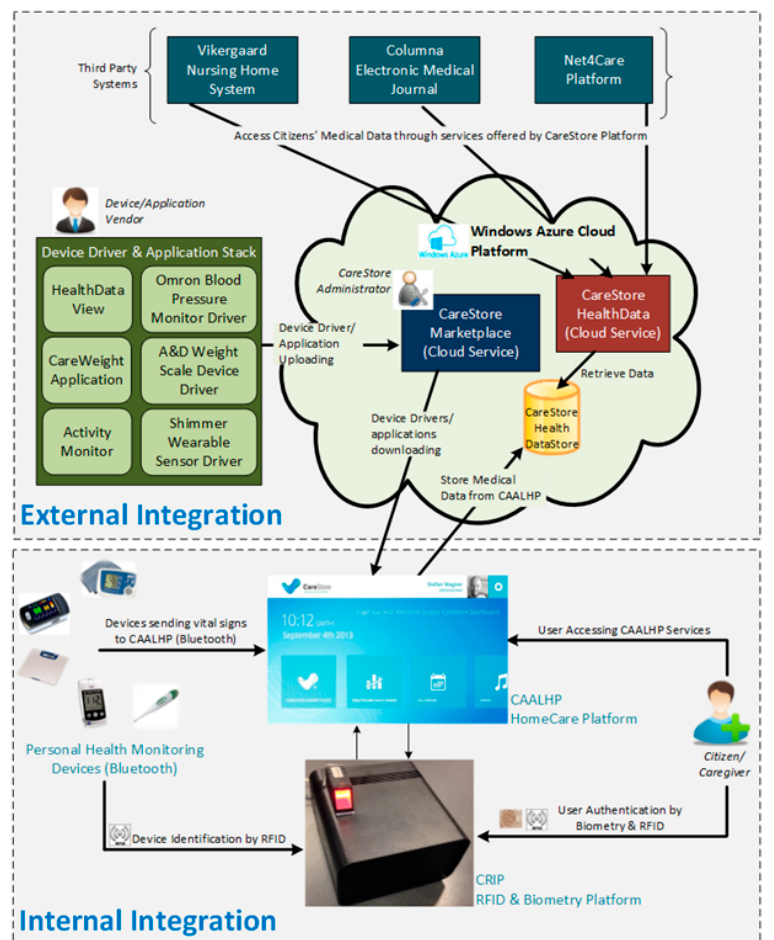
Figure 1. Overview of the CareStore Platform, comprised by three main systems: the CAALHP, the CRIP and the Marketplace. The first two are deployed together on a same space, such as a user’s private home, enabling the integration of local devices and users interaction with the platform. The third allows vendors to upload device drivers and profiles that can be later downloaded and installed on the CAALHP and on the CRIP.